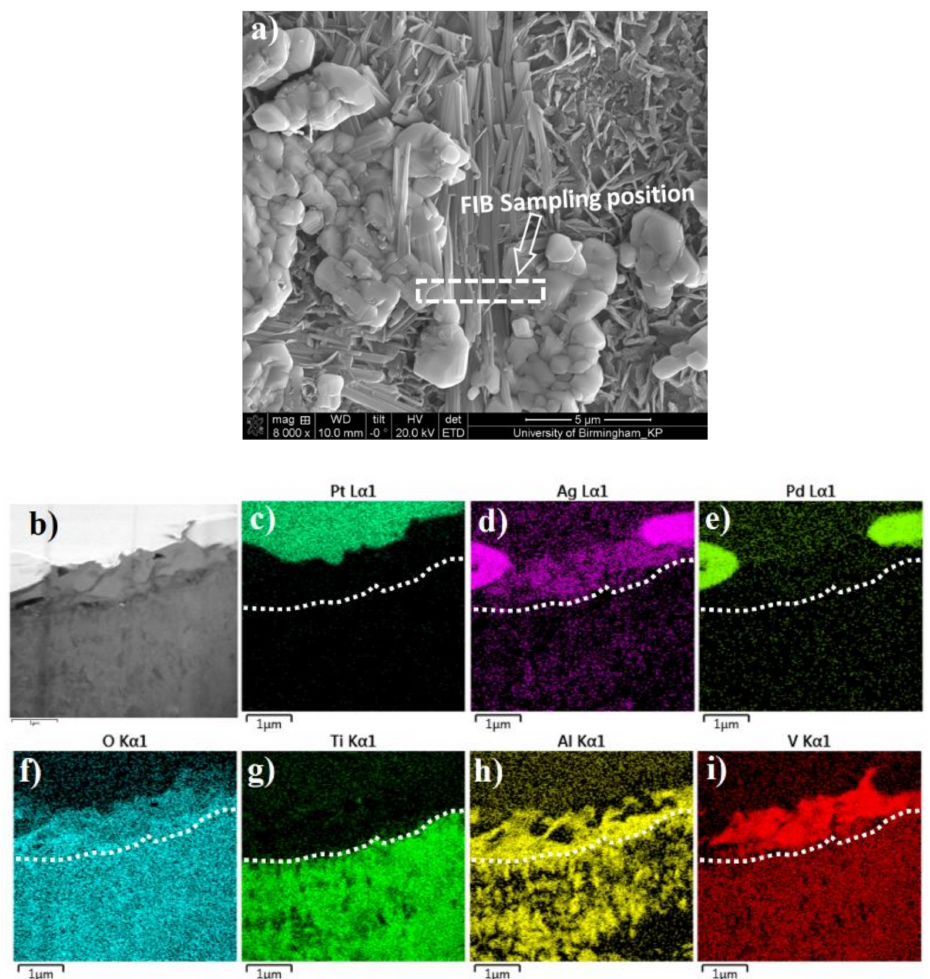
Figure 6. FIB sampling location ( a ); and HAADF image ( b ), of a TEM sample of C3T660-20AgPd coupon; ( c – i ) STEM-EDX element mapping for elements Pt, Ag, Pd, O, Ti, Al, V, respectively. Pt layer shown in ( c ) was deposited during the FIB sample preparation. A dash lines were added to indicate the boundary between the ‘catalytic’ topmost substances and the beneath TiO 2